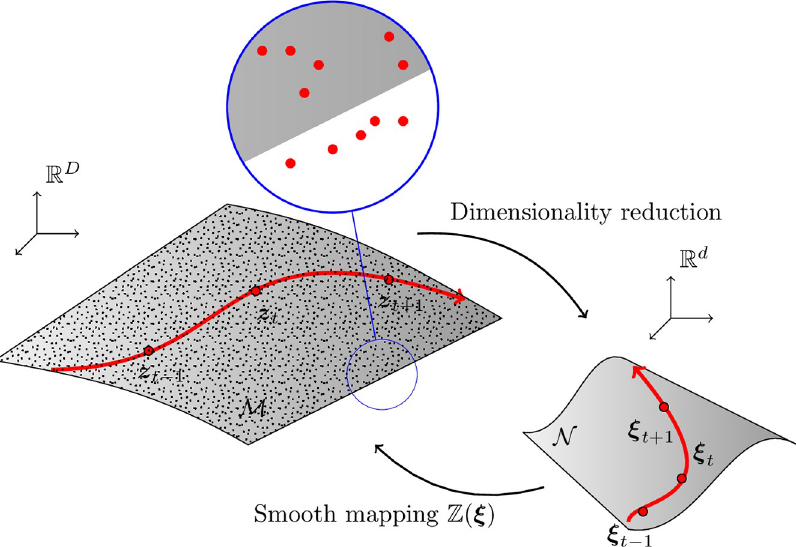
Fig 1. We assume the existence of a slow manifold M on which each fluid lives. We extract synthetic data as vectors in R D from computational simulations. These data are possibly noisy, see the zoomed detail. An example sloshing phenomenon is represented as the red line in phase space. Given the inherent high-dimensionality of the manifold, nonlinear dimensionality reduction techniques will also be applied. This will project the data to a lower dimensionality embedding space in R d , with d � D . We develop structure-preserving integration schemes to integrate the evolution of the system in this low-order manifold. These are then mapped back to the physical space in R D so as to obtain meaningful